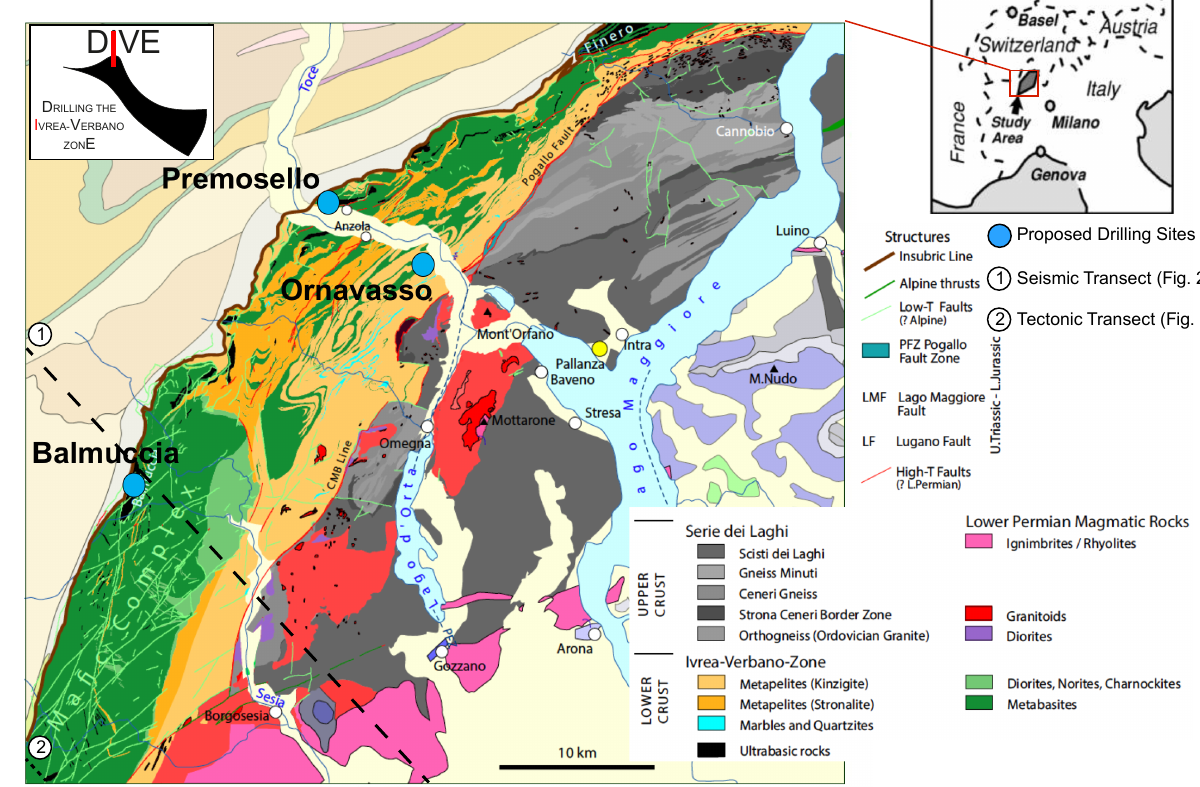
Figure 1. Overview of the geology of the IVZ and adjacent units, simplified after a compilation of James (2001) and Brack et al. (2010). The blue circles indicate the discussed drilling sites for the DIVE project. The inset figure showing the location of the IVZ in Italy is from Rutter et al.